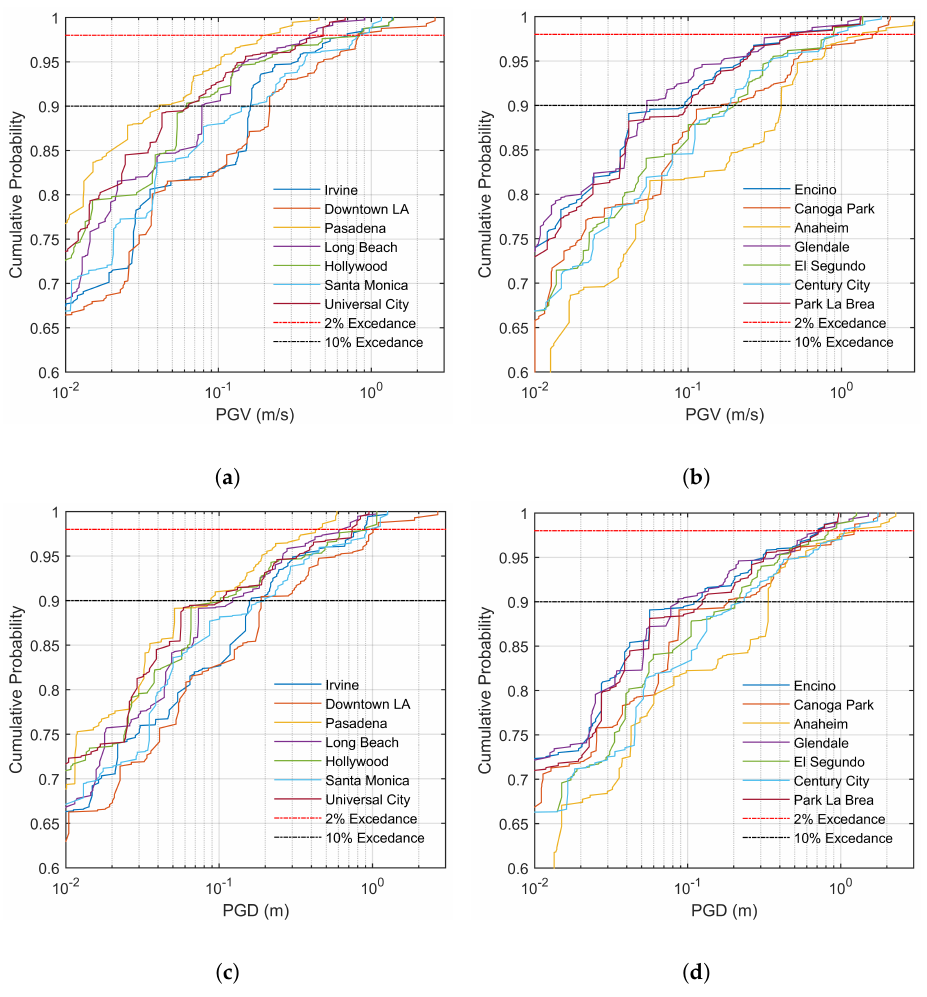
Figure 11. Cumulative Distribution Functions of ( a , b ) PGV and ( c , d ) PGD at the fourteen tall building cluster locations in southern California from San Andreas fault earthquakes over the next 30